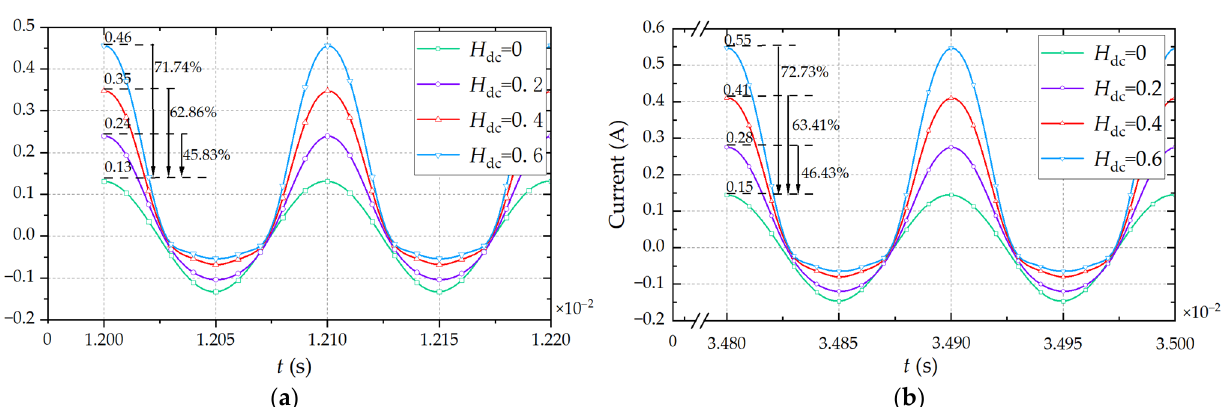
Figure 8. Multi-physics fi eld coupling calculation fl ow chart of HFT.